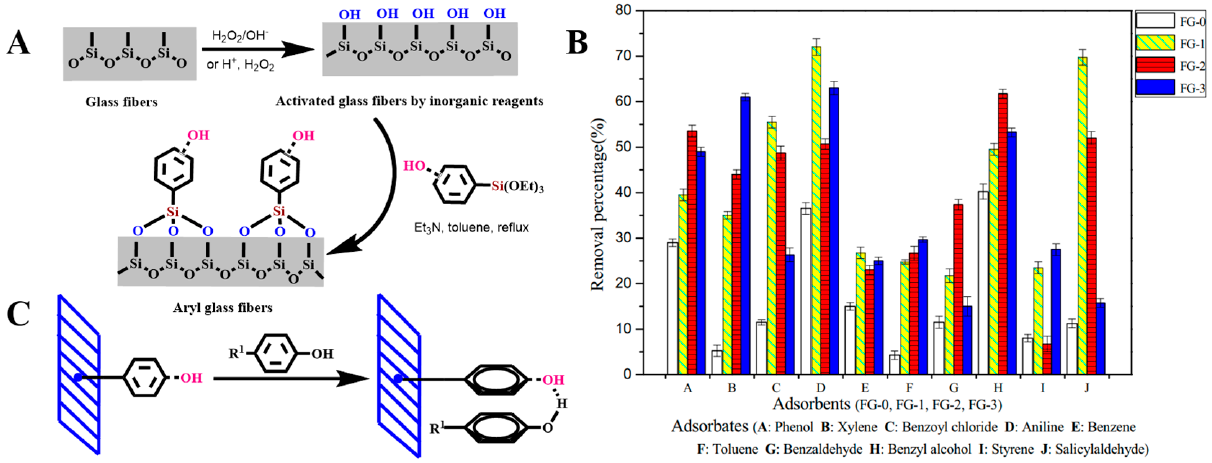
Figure 11. ( A ) Preparation of the activated glass fibers and aryl glass fibers. ( B ) The removal per- centages for the four glass fiber types with regard to specific volatile benzene − based compounds (bars show standard deviations for n = 4); one of the FG − 0 (untreated glass fibers), FG − 1 (30% H 2 O 2 ), FG − 2 (NaOH + ethanol + distilled water) and FG − 3 (98% H 2 SO 4 + 30% H 2 O 2 ). ( C ) A diagram showing the adsorption of aromatic compounds by the glass fibers via both hydrogen bonding and π – π conjugate interactions. Reproduced with permission from reference [22]. Copyright 2021 Envi- ronmental Science and Pollution Research International .